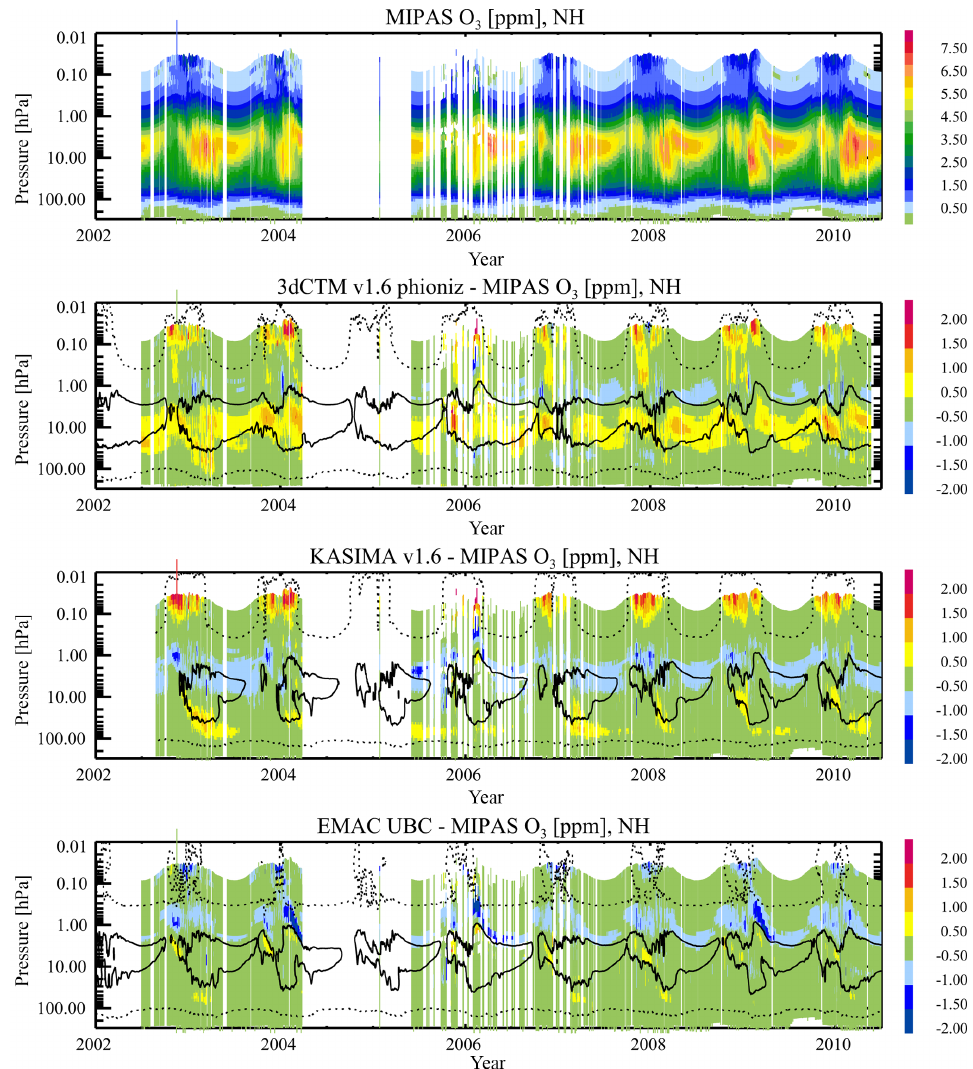
Figure 9. Same as Fig. 8 but for high northern (70–90 ◦ )